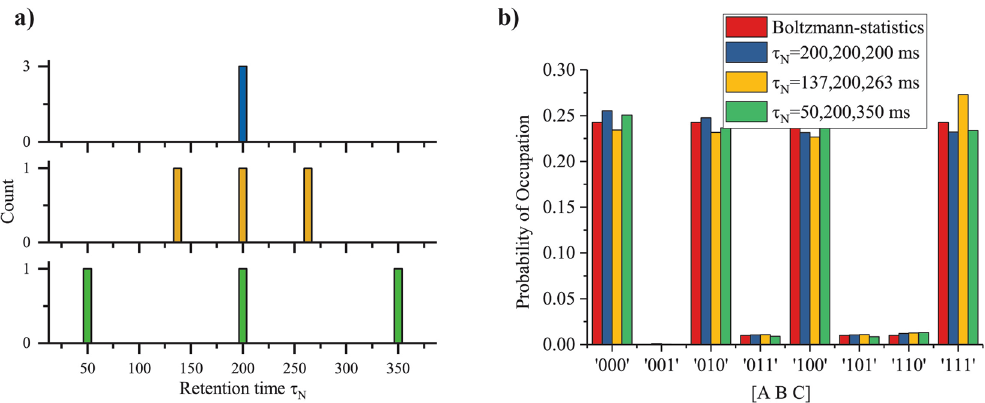
Figure 6. p-bit retention time τ N . The retention time τ N of the p-bits is varied while maintaining a sampling time τ sample = 1 ms. This can be done by changing the variable τ N defined in Algorithm 1. In the most trivial case all 3 p-bits have the same τ N = 200 ms, while in the other two they are distributed over the mean as shown in histogram of τ N in ( a ) with a spread of ± 33% and ± 75%. The steady-state statistics for each of the 3 cases shown in ( b ) are good matches with Boltzmann Law. This shows that as long as τ sample is much greater than τ N the system functions properly.